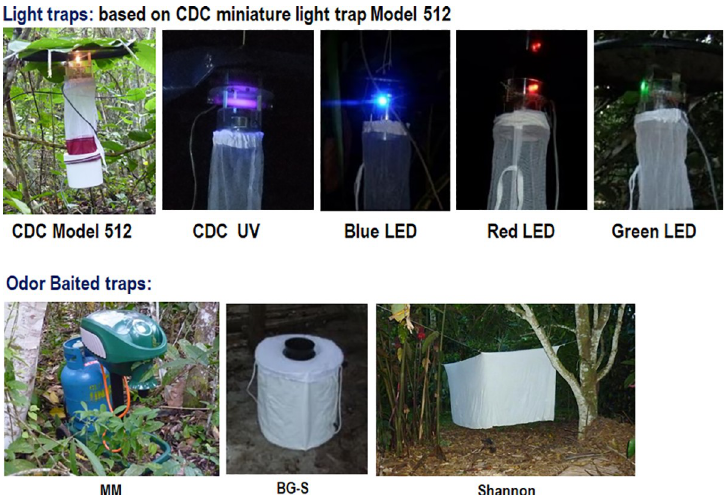
Fig 2. Different trap types used for sand fly collections. LED colors were adapted from the standard Mini CDC light trap Model 512 (CDC). MM: Mosquito Magnet Model Independence baited with CO 2 and R-Octenol; BG-S: BioGents BG Sentinel baited with